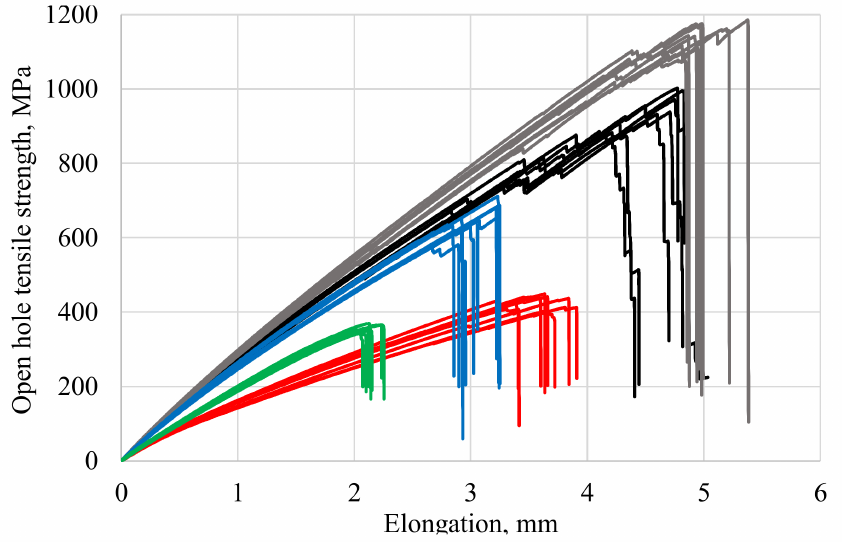
Figure 4. Loading diagrams of CFRP specimens with an open hole in tension (according to ASTM D 5766) with different reinforcement schemes: Type 1—black curves; Type 2—grey curves; Type 3—red curves; Type 4—blue curves; Type 5—green